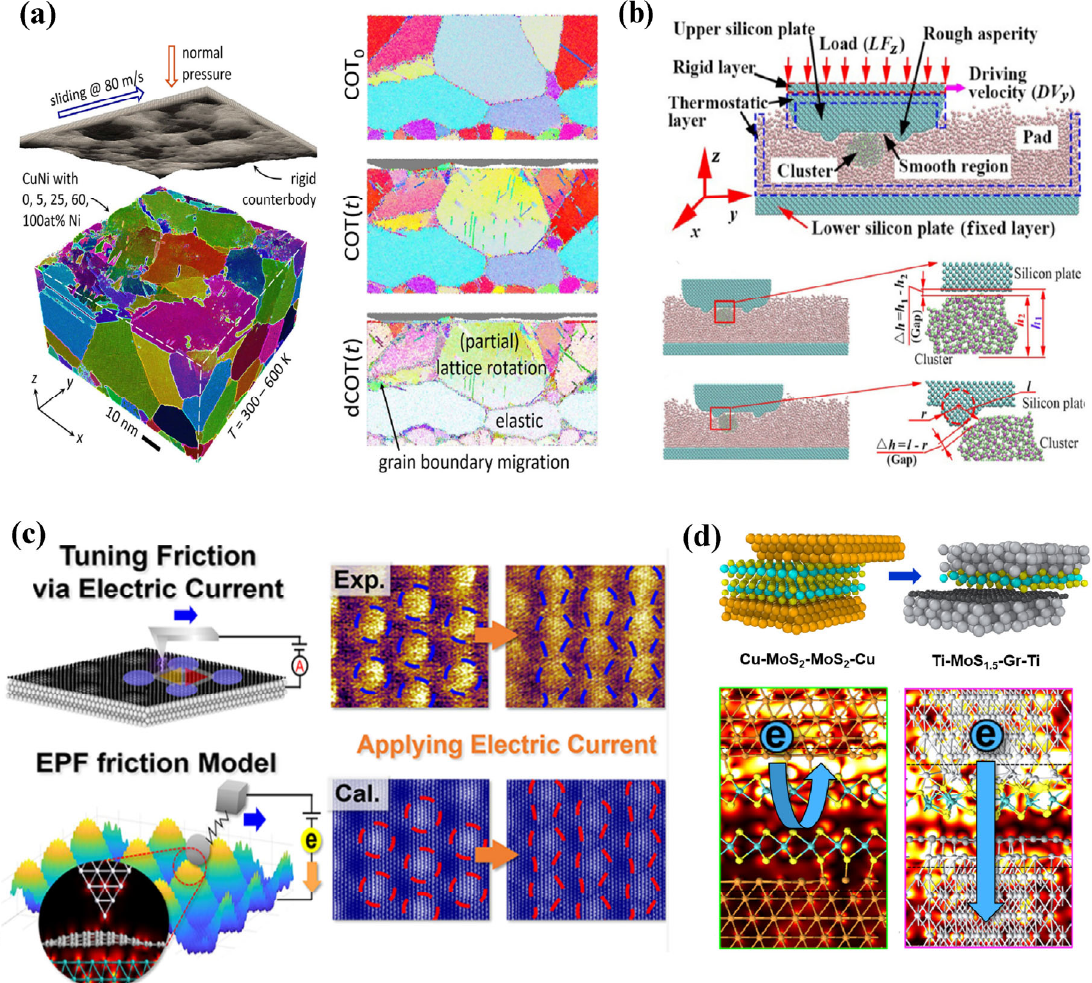
Fig. 77 Mechanism of friction and wear at atomistic scale [931, 934, 935, 937]. Reproduced with permission from Ref. [931], © The author(s), 2021; Reproduced with permission from Ref. [934], © The author(s), 2022; Reproduced with permission from Ref. [935], © American Chemical Society, 2022; Reproduced with permission from Ref. [937], © The author(s),